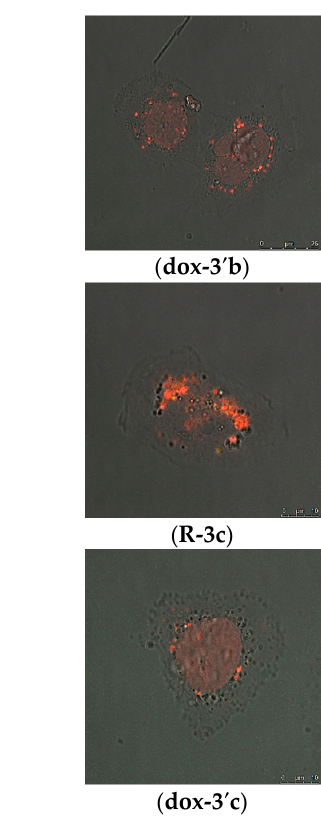
Figure 3. Intracellular distribution of DOX delivered by MSN@PDA-COP particles are represented in the images above in MDA-MB-231 cells over a duration of 24, 48, and 72 h. Images are denoted based on particle type ( R -rod , S -sphere), concentration ( 1 -12.5 µg/mL, 2 -18.75 µg/mL and 3 -25 µg/mL) of DOX-loaded particles and time ( a -24 h, b -48 h and c -72 h). The prime ( ‘ ) indicates the corresponding concentrations of free DOX. Live cell images of MDA-MB-231 cells incubated with DOX-loaded particles and free DOX for ( a ) 24 h, ( b ) 48 h and ( c ) 72 h (red color indicates DOX). The images were taken using 63X oil objective lens. Scale bar = 25 µm for all images.